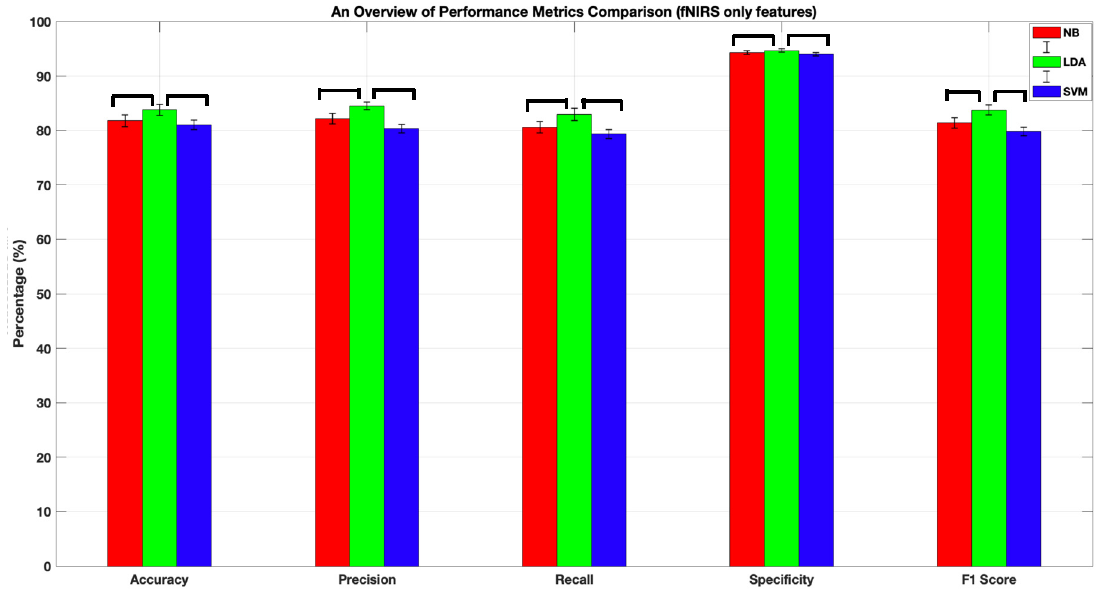
Figure 6. Classification performances of NB, LDA, and SVM algorithms after being trained with fNIRS-derived features (i.e., GE cm and GE dm ). Horizontal lines depict statistically significant differ- ences between performances of different algorithm pairs. All algorithms achieved accuracy, precision, recall, and F1-score performances above 80%, while the specificity scores were above 94%. LDA performed significantly higher than both SVM and NB in terms of accuracy, precision, recall, specificity, and F1-score. The error bars represent standard error of the mean performance after 10 runs of a 10-fold C.V.